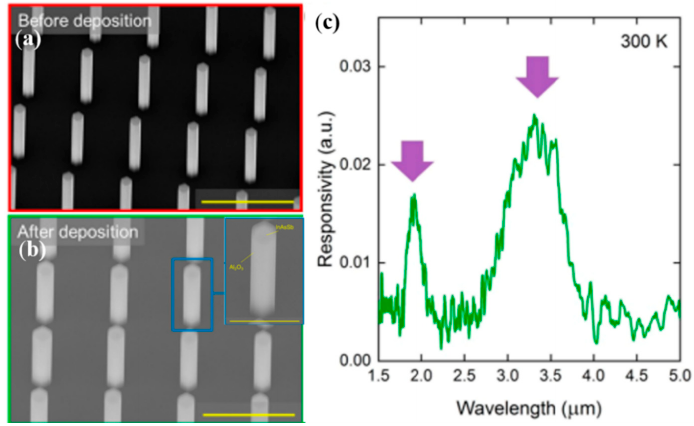
Figure 2. SEM images of ( a ) InAsSb nanowires and ( b ) InAsSb nanowires with (cid:31)60 nm Al 2 O